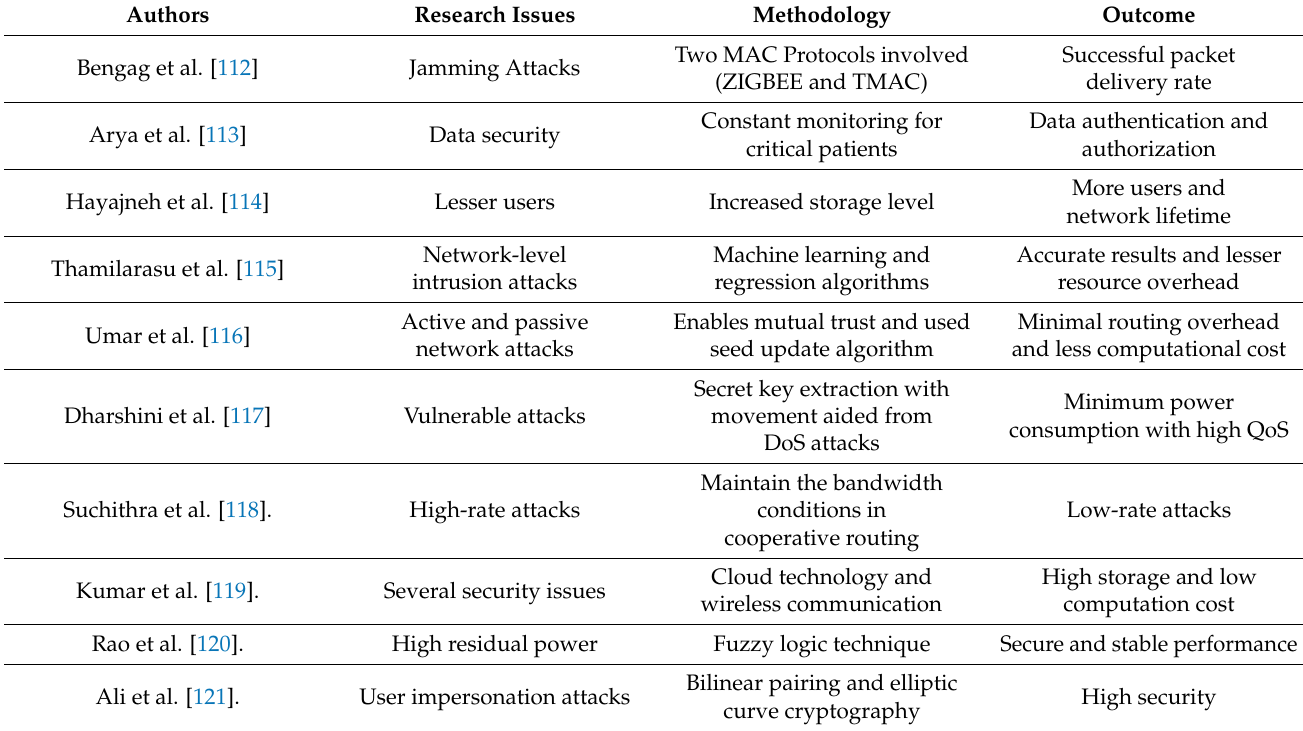
Table 12. Comparison of security techniques in